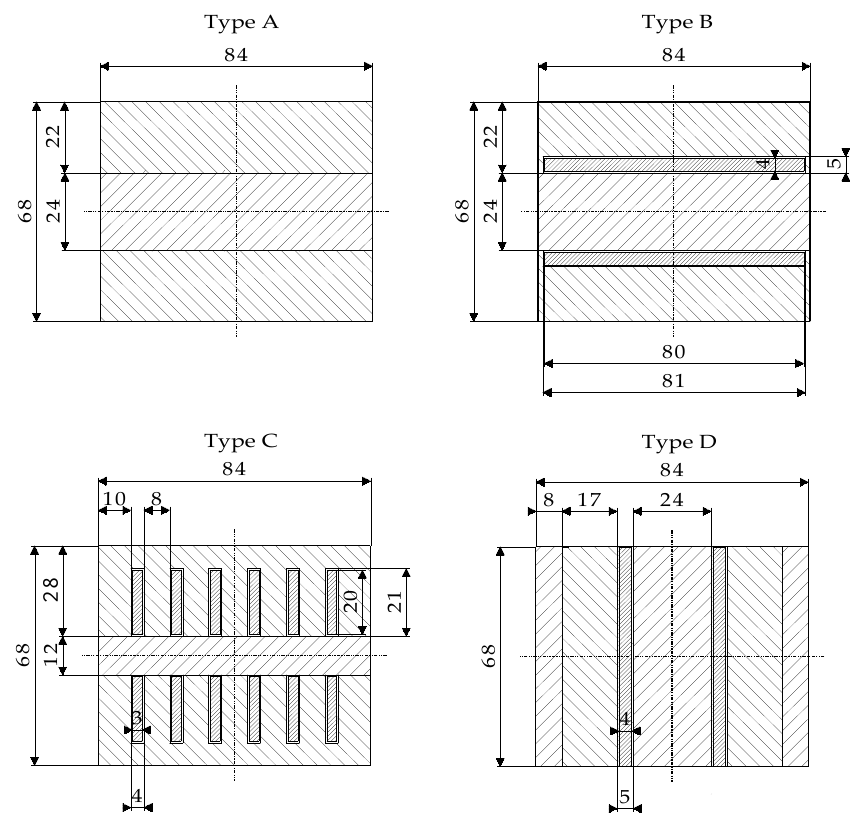
Figure 2. Cross sections of the type A, B, C, and D specimens (measurements in mm).